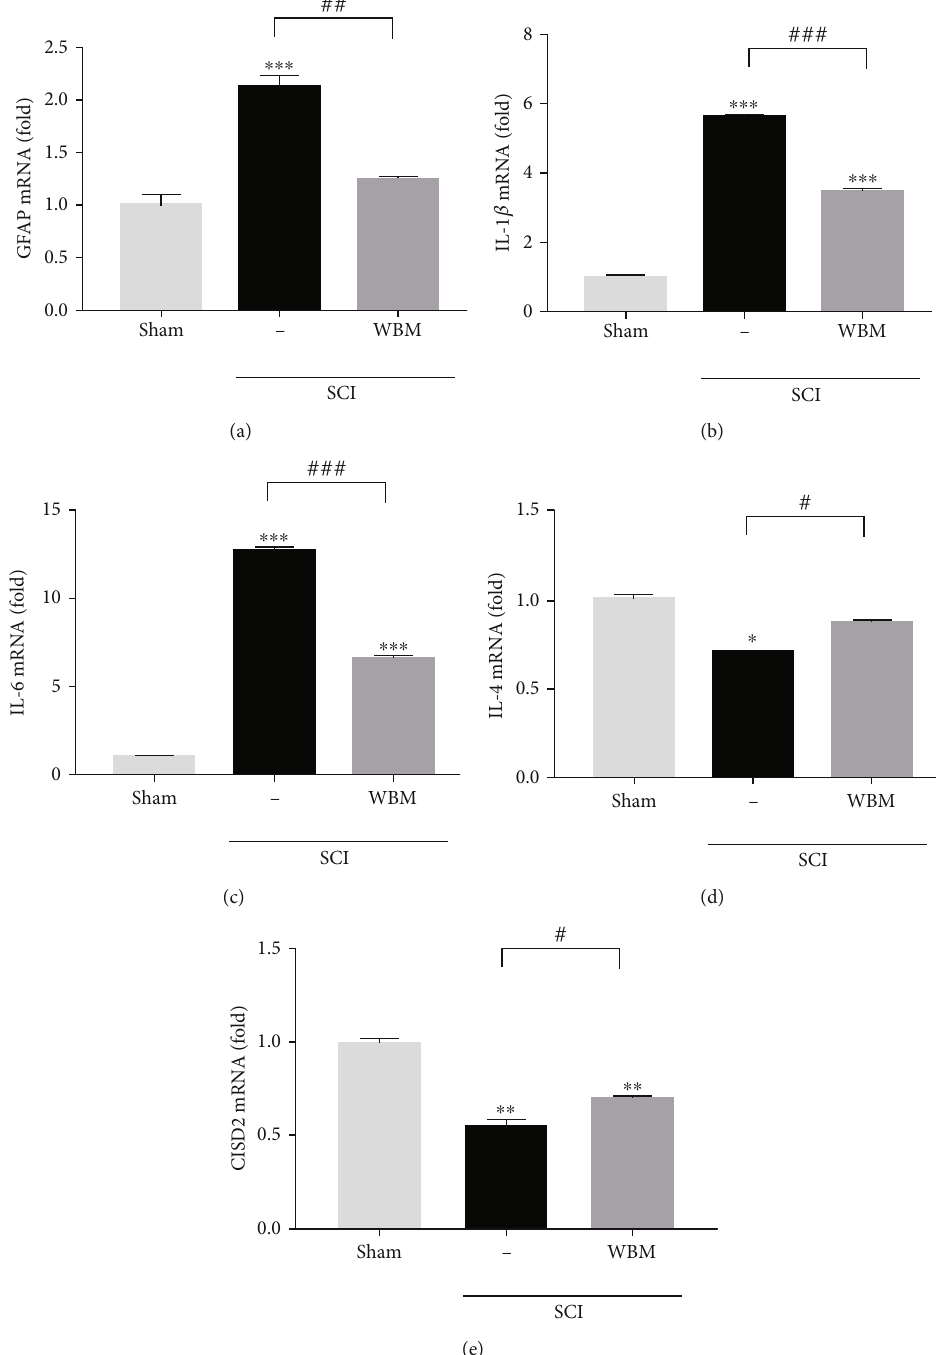
Figure 4: Traumatic insults upregulated GFAP and neuroin fl ammatory mediators and downregulated CISD2 mRNA expression in vivo 24h after spinal cord hemisection in mice. WBM can in vivo rescue the abovementioned detrimental e ff ects. Results of mRNA expression of GFAP (a), IL-1 β (b), IL-6 (c), IL-4 (d), and CISD2 (e) for 3 conditions. Vertical bars indicate the mean ± standard errorof the mean (SEM) of mRNA expression ( n = 3 ). ∗∗ P < 0 : 01 vs. control, ∗∗∗ P < 0 : 001 vs. control, ## P < 0 : 01 , and ### P < 0 : 001 indicate a signi fi cant di ff erence. Pair-wise multiple comparisons between groups were performed using the Newman-Keuls